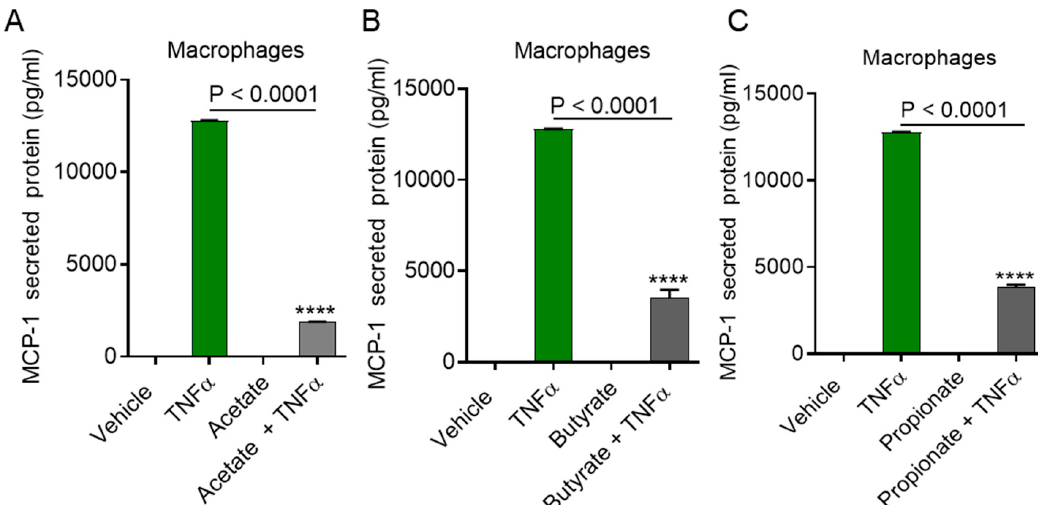
Figure 3. Impact of acetate on TNF α induced MCP-1 expression in macrophages. Monocytic cells derived macrophages were stimulated with acetate (100 mM), butyrate (2 mM), propionate (10 mM), and TNF α (10 ng/mL) alone or in combination for 24 h. ( A – C ) Secreted MCP-1 protein in culture media was determined by ELISA. The results obtained from three independent experiments are shown. All data are expressed as mean ± SEM (n = 3). **** p < 0.0001 versus TNF α alone.